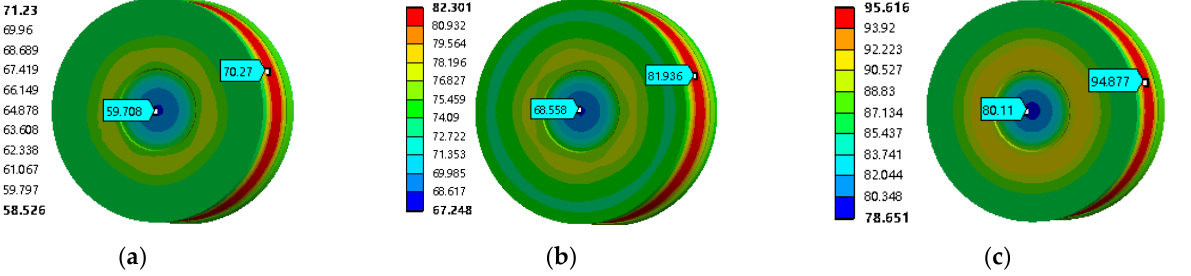
Figure 15. The steady-state temperature distribution of DHEG enclosure at 3000 rpm: ( a ) 1 A; ( b ) 2 A;